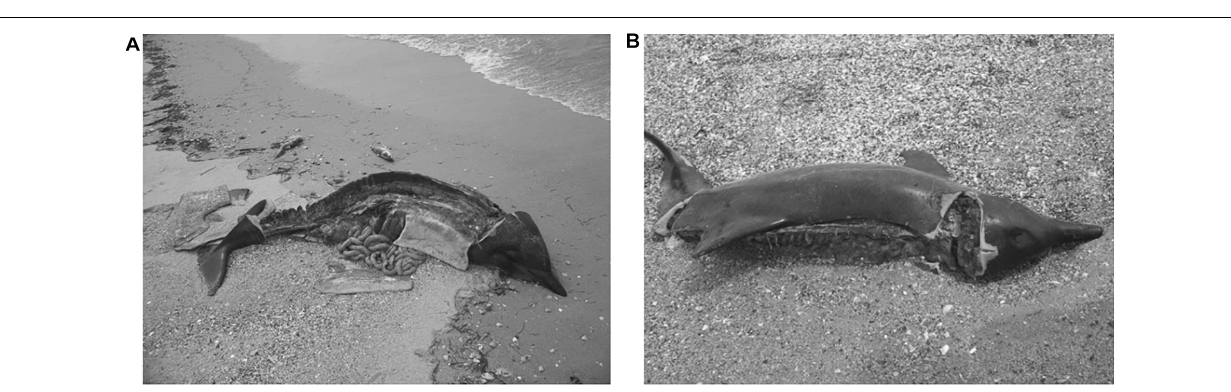
FIGURE 3 | Two individuals of Sotalia guianensis (A,B) found in northern region in 2019 with signs of anthropogenic interaction. In both cases, the dorsal muscles were